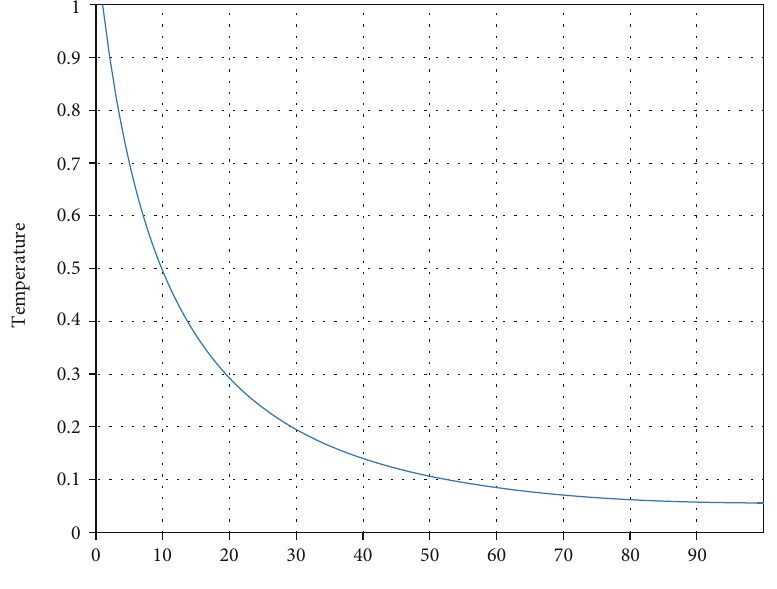
Figure 4: Thermal pro fi